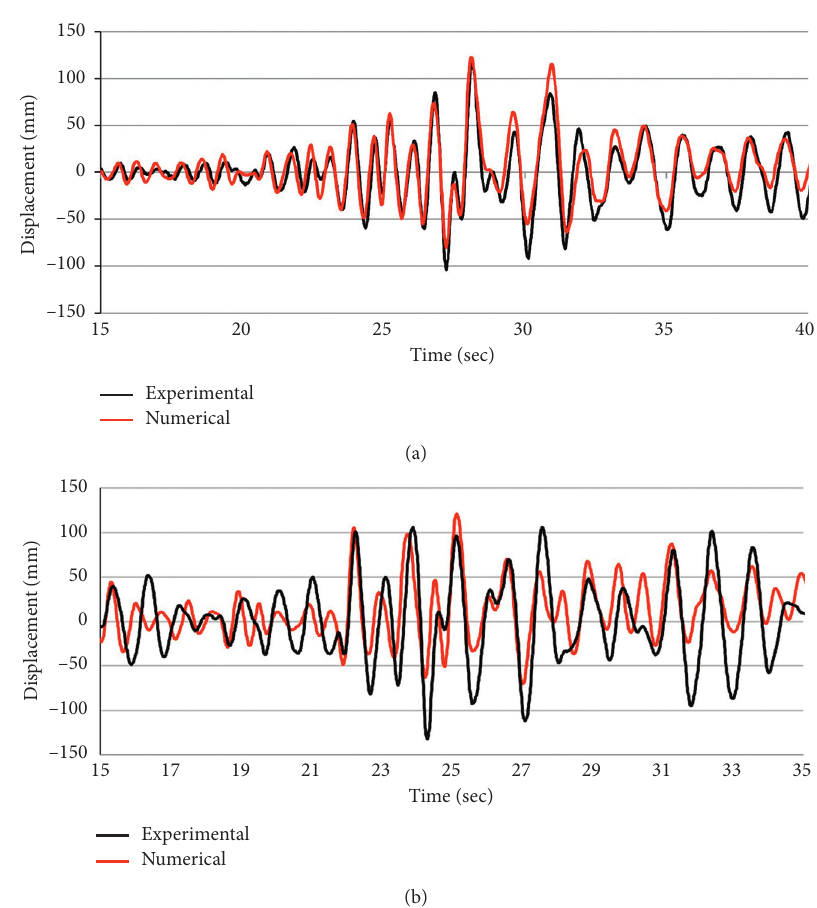
RC having RC haunch below beam only. (b)